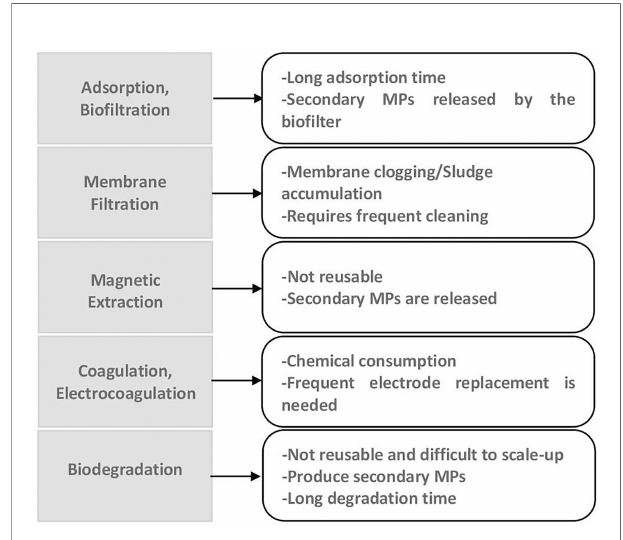
FIGURE 1 | Drawbacks of some of the MPs removal